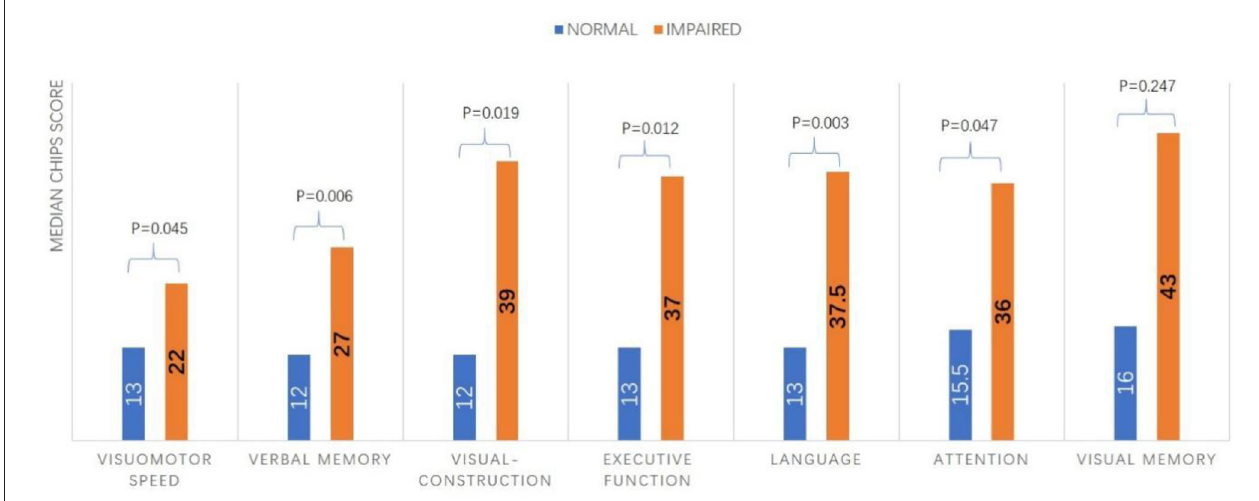
FIGURE 3 | Comparison of the CHIPS score according to impairment in each cognitive domain.